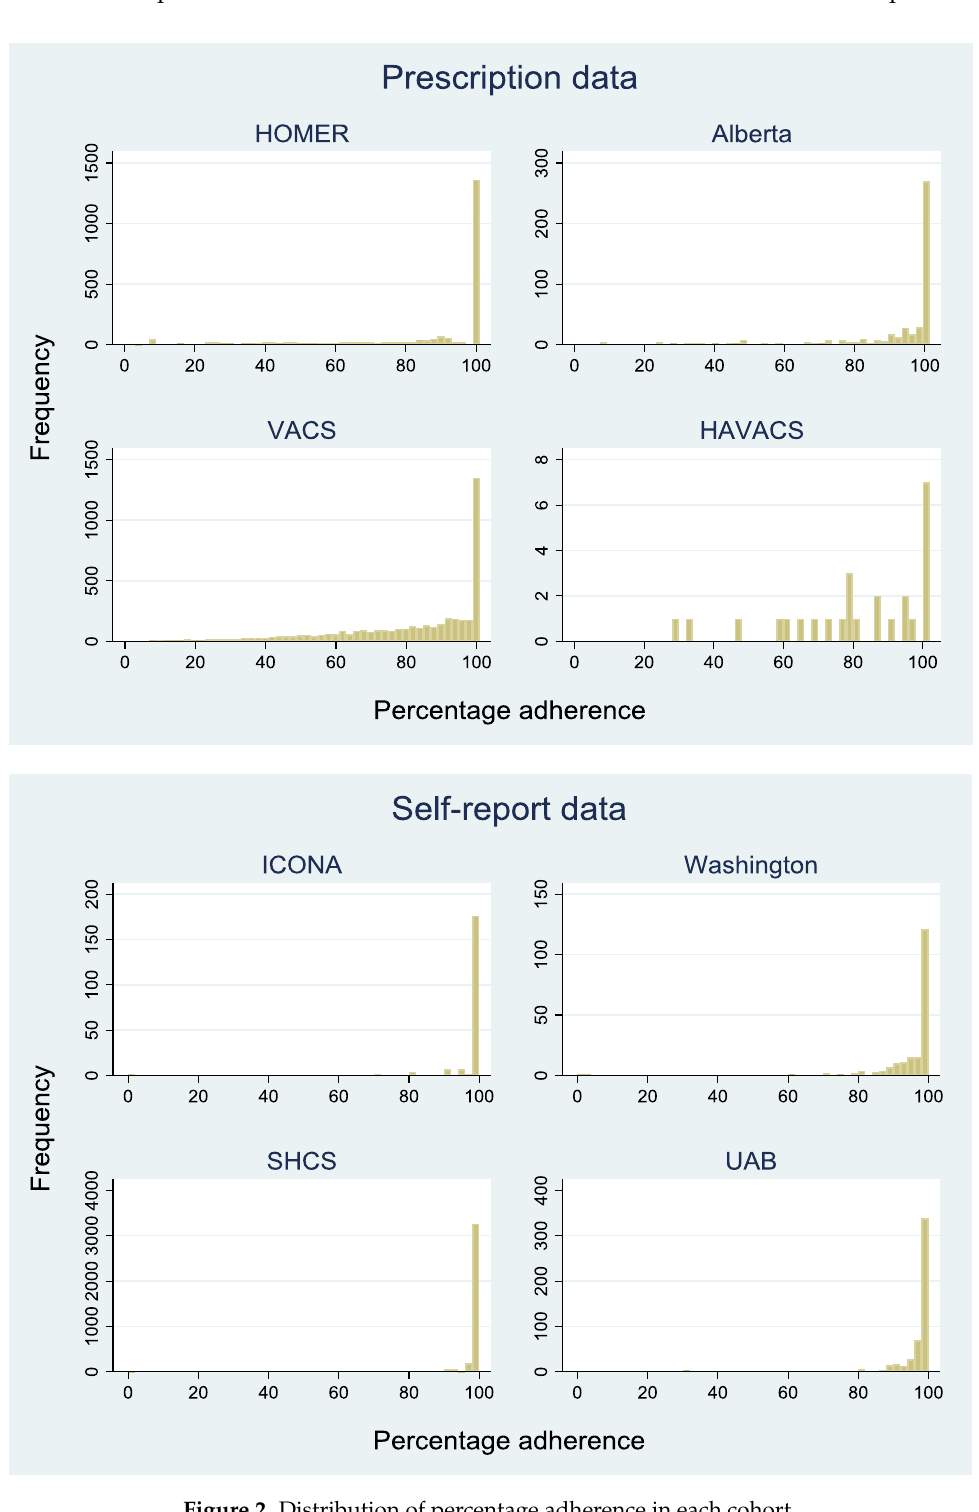
Figure 2. Distribution of percentage adherence in each cohort.